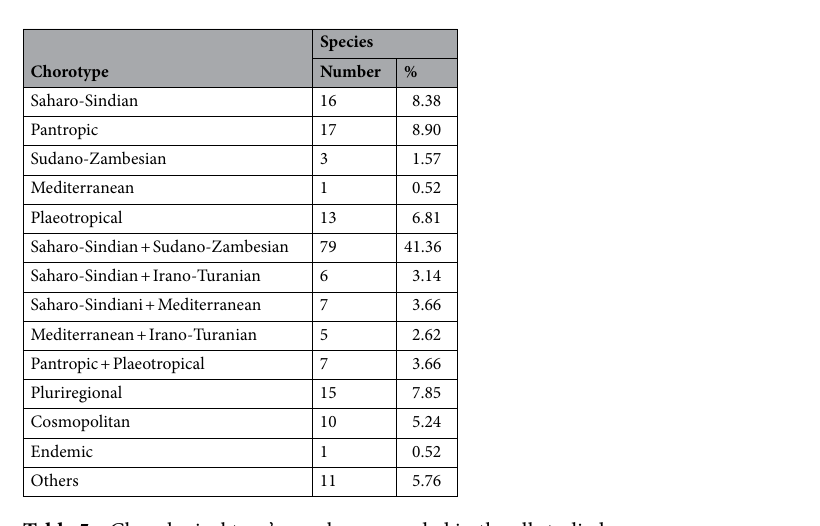
Table 5. Chorological type’s numbers recorded in the all studied